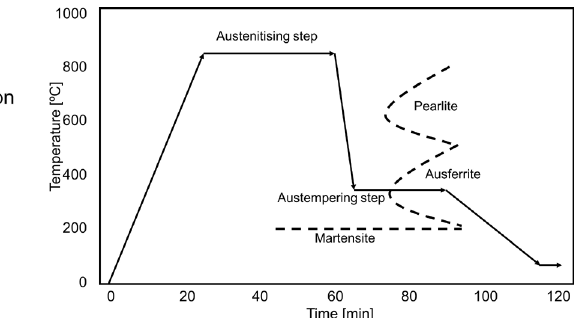
Figure 4. Y-block dimensions.